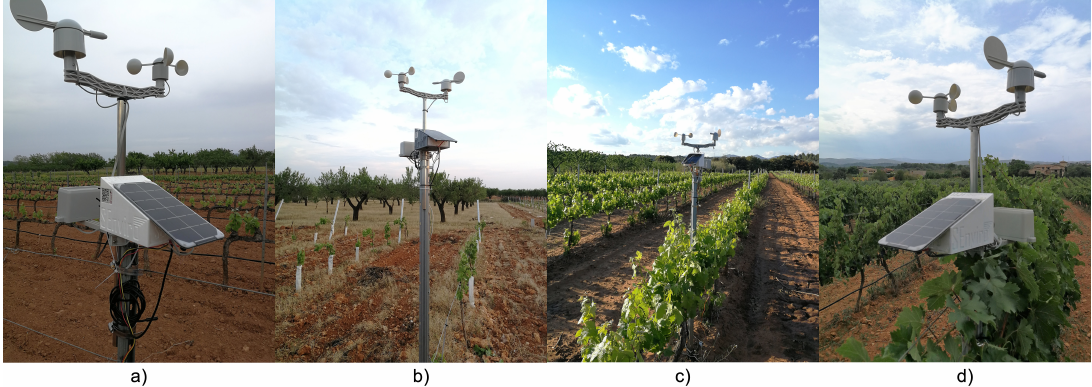
Figure 11. Some pictures about all SEnviro node deployments on vineyards.